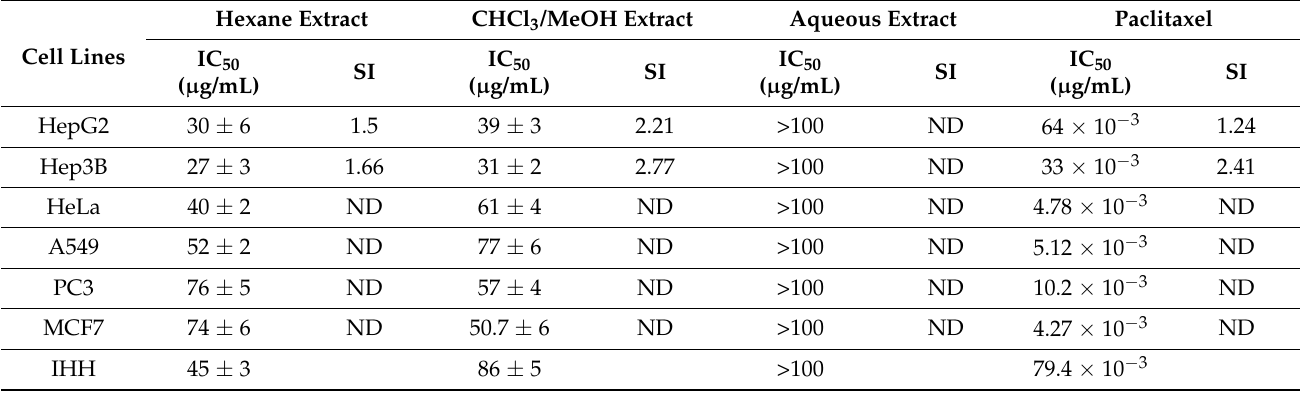
Table 2. Cytotoxic activity of C. incisa leaves